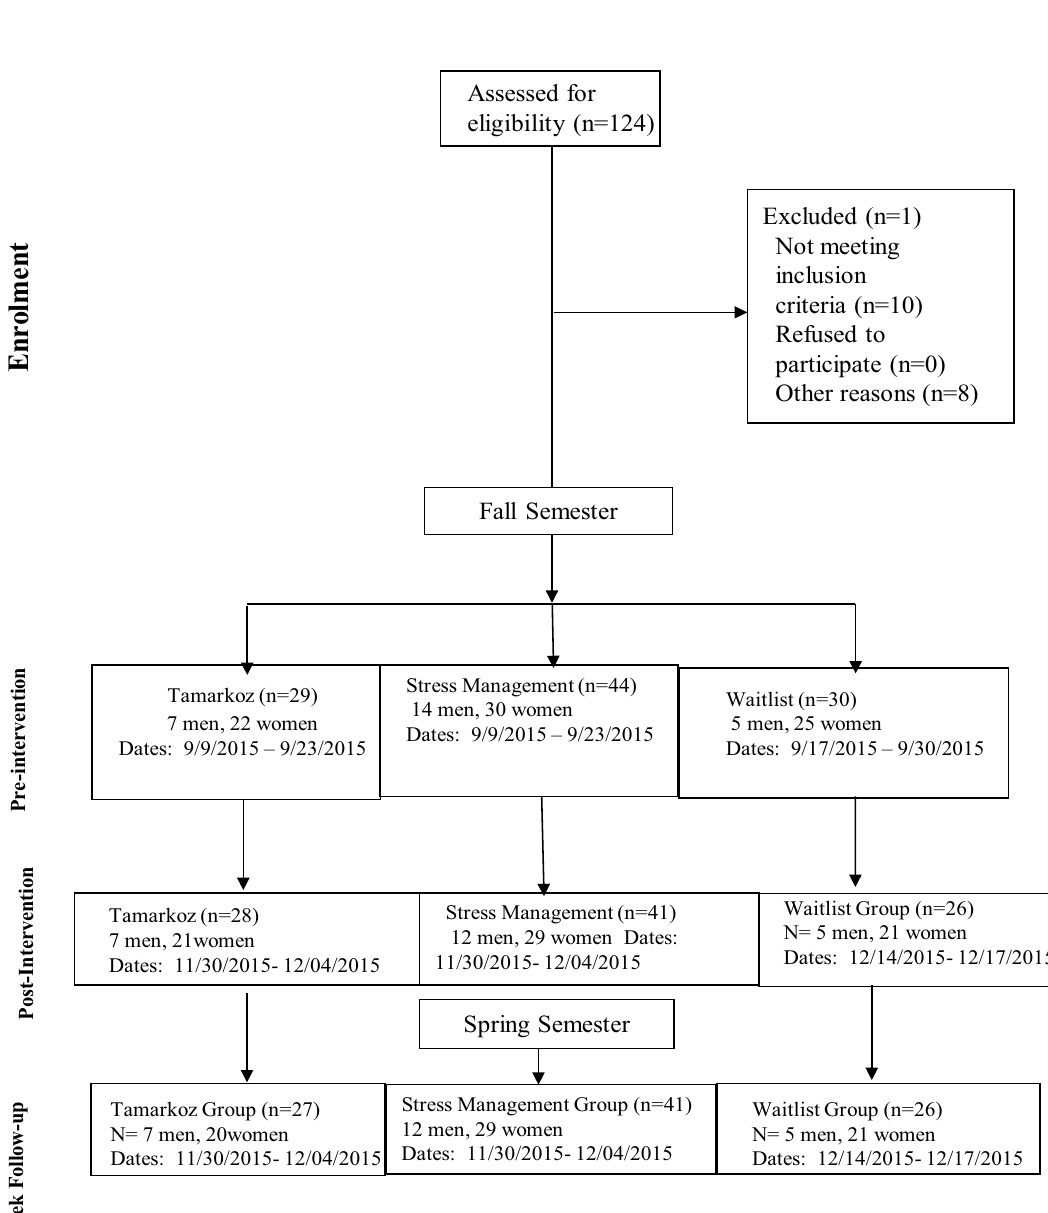
Figure 1. Recruitment and data